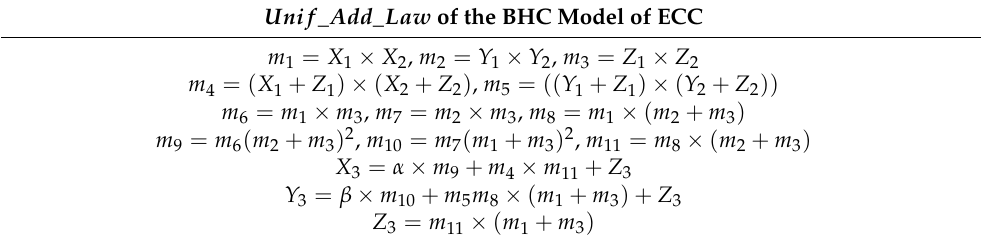
Table 2. Unif _ Add _ Law for BHC (published in